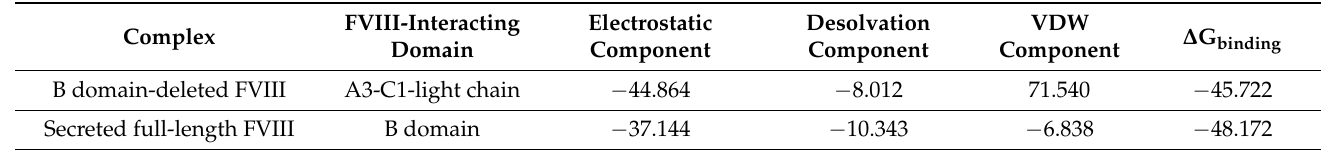
Figure 3. VWF/BDD-FVIII complex. ( A ) BDD-FVIII is represented in cyan (light-chain) and green cartoon, VWF is represented with magenta cartoon. ( B ) Surfaces representation as mesh. Capital letters refer to protein domains of FVIII. Table 1. Pydock output. Predicted interactions between FVIII structure models and von Willebrand factor fragment (PyDock).